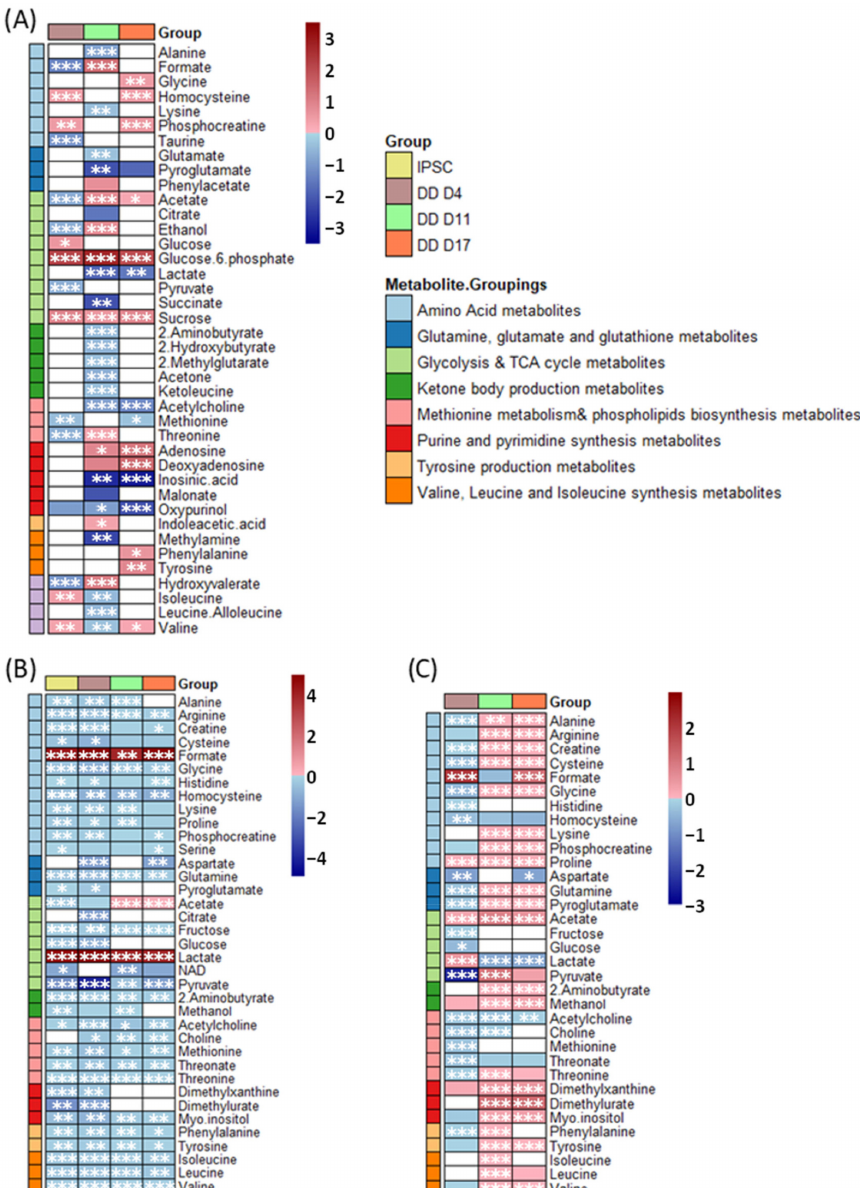
Figure 4. Fold change analysis of key metabolites for pluripotent IPSC and directed differentiation stage 1 (DD D4), 2 (DD D11) and 3 (DD D17). Fold change analysis of ( A ) intracellular metabolites with respect to pluripotent (IPSC) metabolite levels; ( B ) extracellular metabolites with respect to cell-free control; ( C ) extracellular metabolites with respect to IPSC levels. Red cells indicate a fold- change increase, blue cells indicate a fold-change decrease. Cells left white were found to be neither significantly different (<0.05 FDR-adjusted p -value) nor with VIP > 1 (by multivariate discriminant analysis). Asterisks indicate FDR adjusted p -values < 0.05 (*), < 0.005 (**) or < 0.001